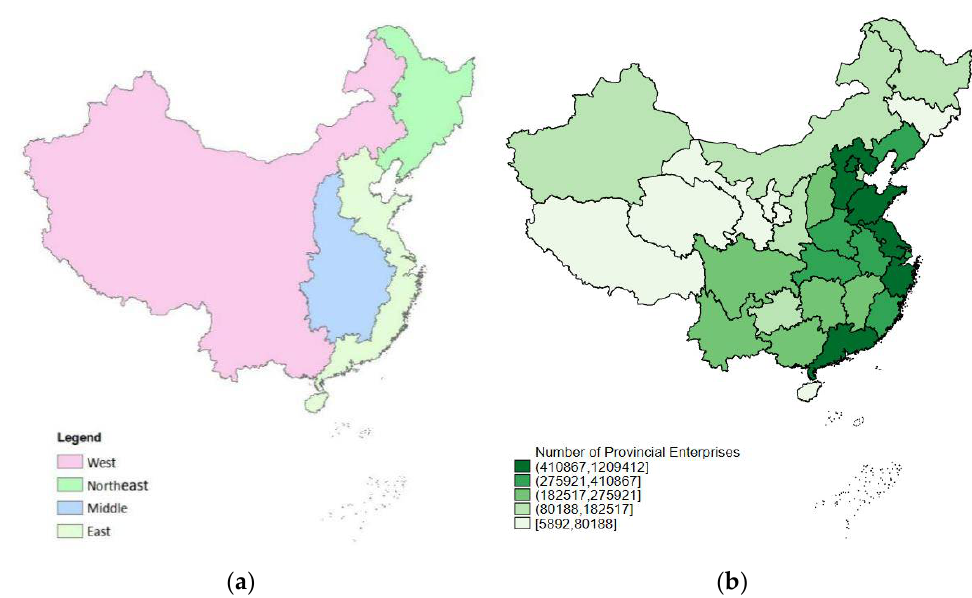
Figure 5. ( a ) Geographical divisions of China’s mainland economic zones (excluding Hong